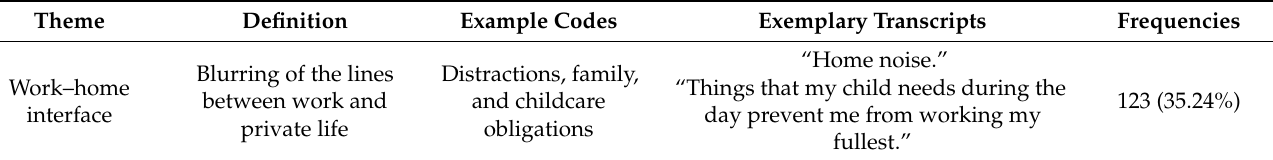
Table 1. Themes and Codes Identified from Study 1: Challenges of Remote Work and Virtual